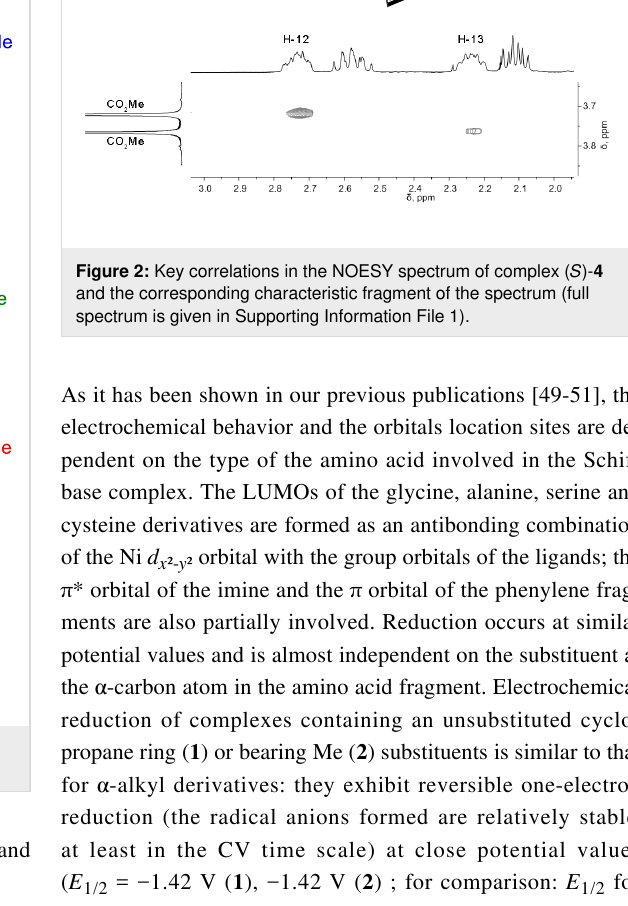
complexes of ( S )- N -( N -benzylprolyl)aminobenzophenone and ʟ -amino acids [48].